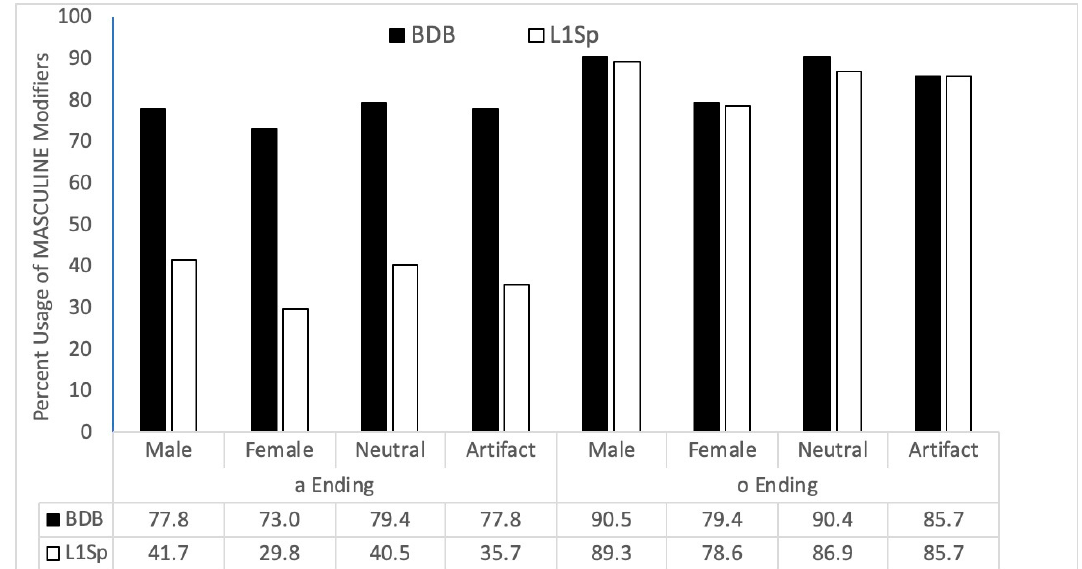
Figure 2. Production of MASC modifiers with - a vs. - o pseudonouns, in reference to male, female, and non-gendered animate objects and artifacts.